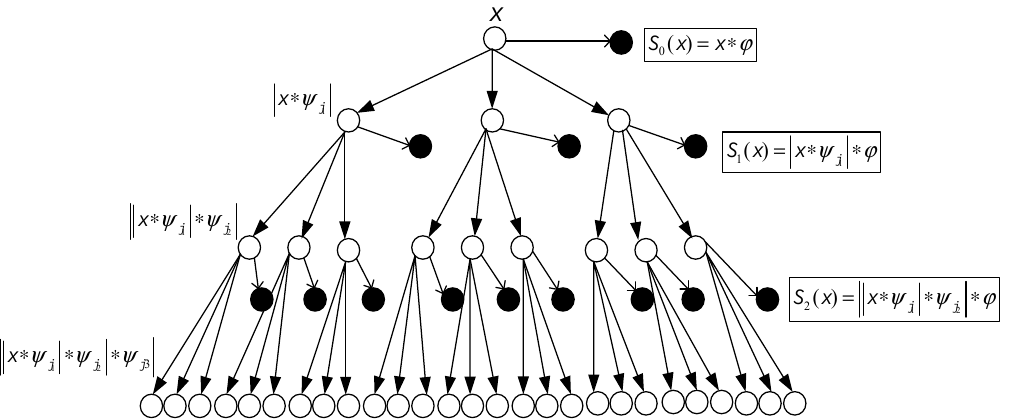
Figure 1. Wavelet Scattering Decomposition Structure.